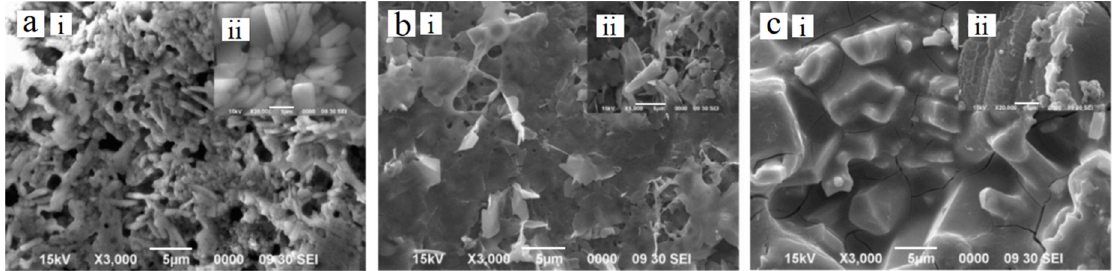
Figure 3. HAp coating on Ti alloy sintered at ( a ): 600 °C, ( b ): 700 °C and ( c ): 800 °C. Note: (i,ii) indicate different magnification of the micrographs [117].